Question: Does the figure show an increasing or a decreasing trend?
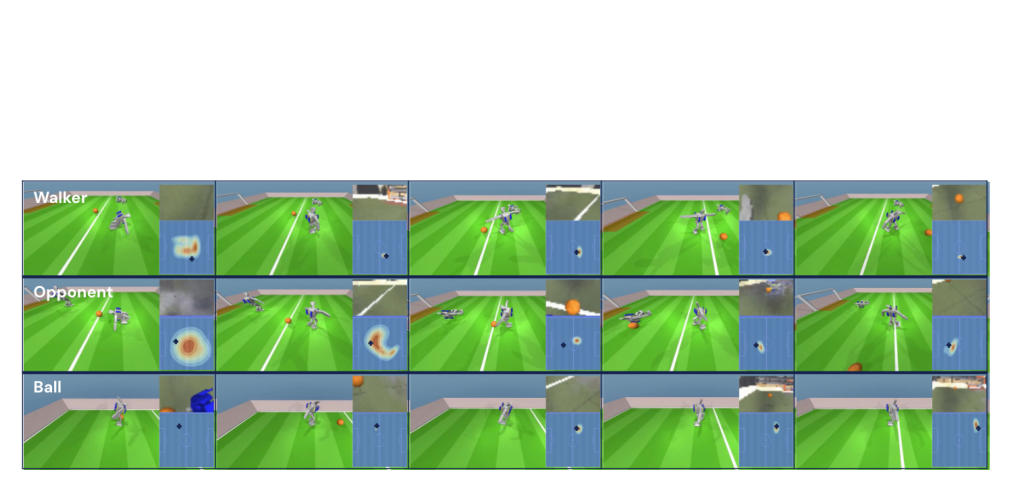
Answer: increasing